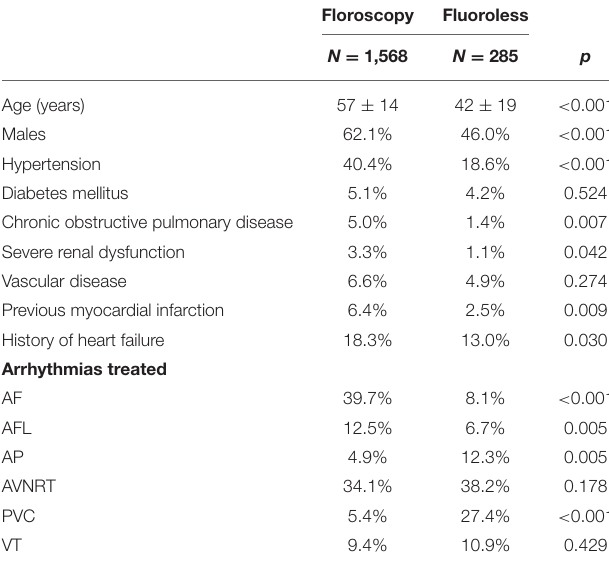
TABLE 1 | Characteristics of patients treated with and without fluoroscopy.